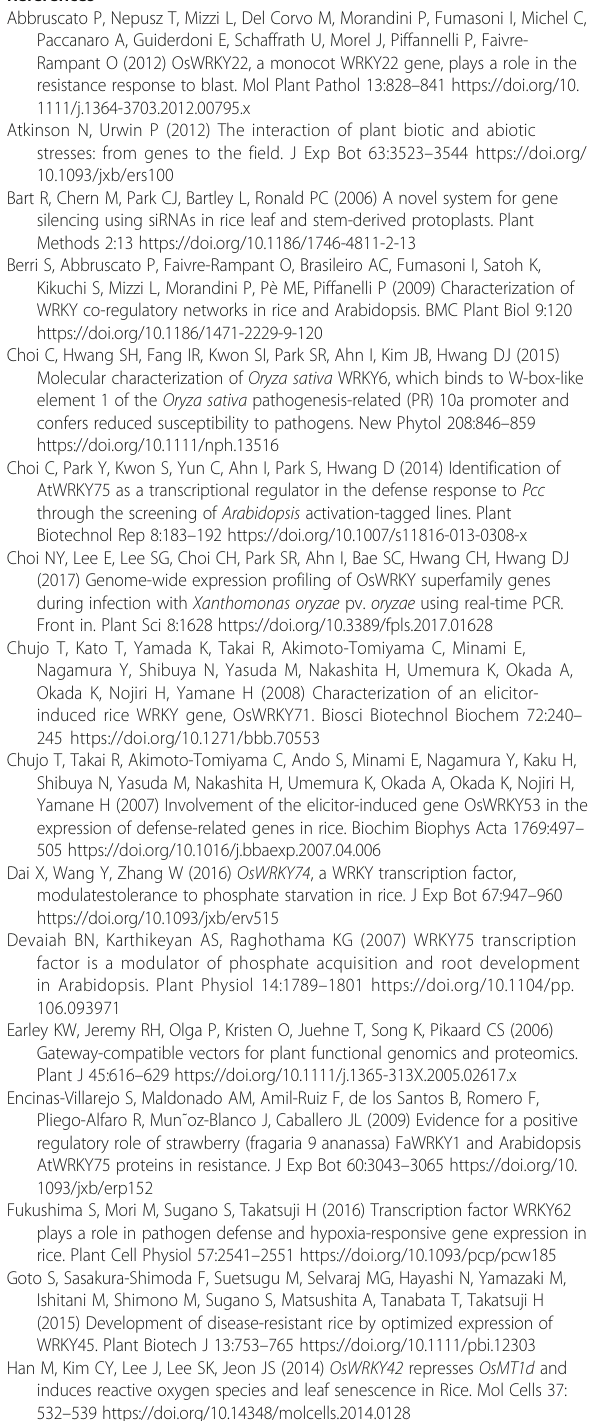
Figure S4. W-box and W-box-like element 1 (WLE1) depicted in CHIT2 and RAB21 promoter. Figure S5. Drought response assays for plants over (ox)- or under-expressing (RNAi-knock-down; kd) OsWRKY11 . Supplementary experimental procedures. (DOCX 130